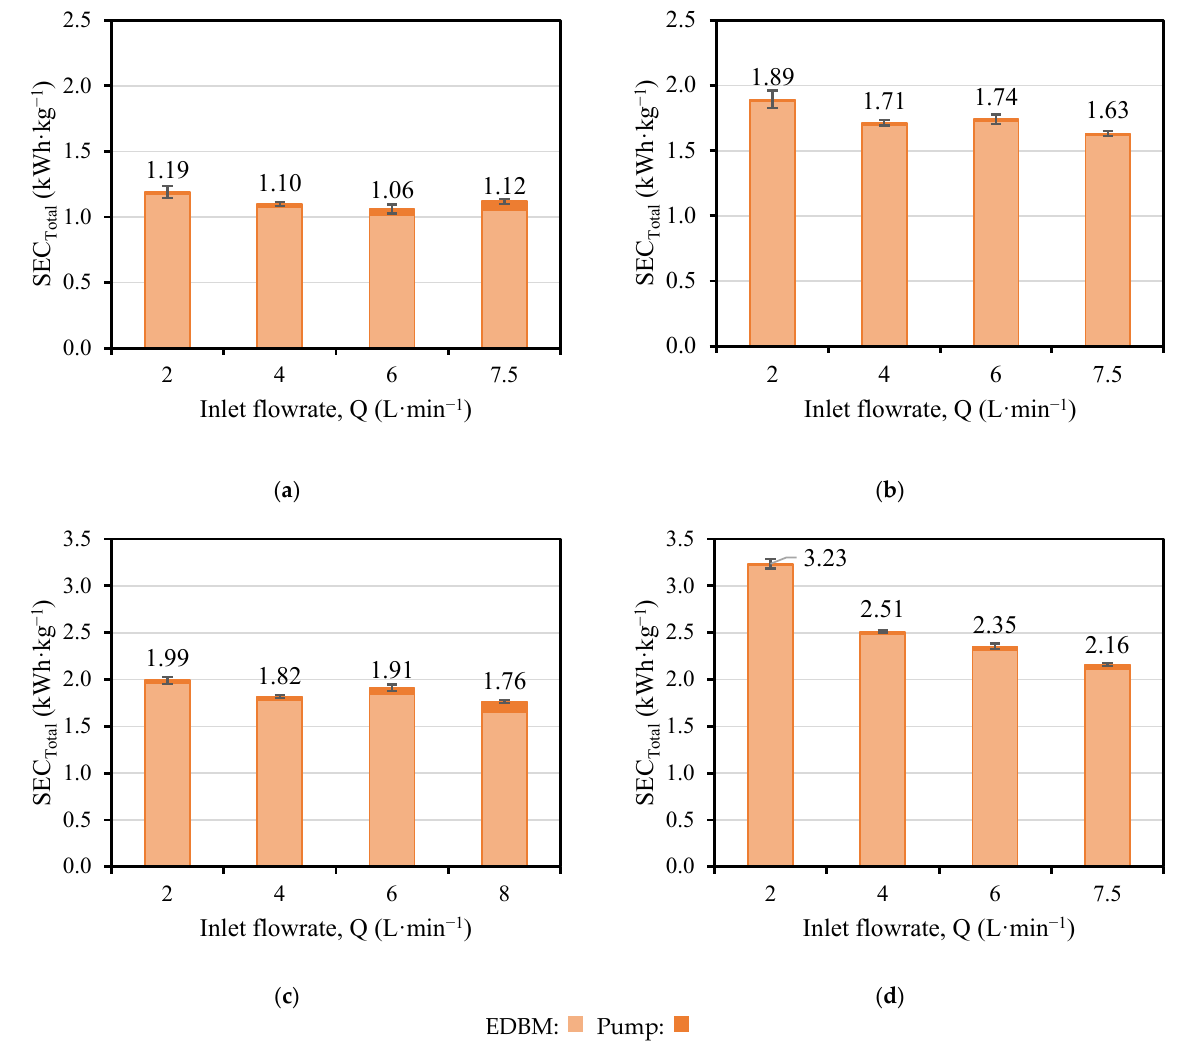
Figure 9. Values of SEC Total versus flowrate: ( a ) T ‐ 200 ‐ I; ( b ) T ‐ 400 ‐ I; ( c ) T ‐ 200 ‐ F; ( d ) T ‐ 400 ‐ F.